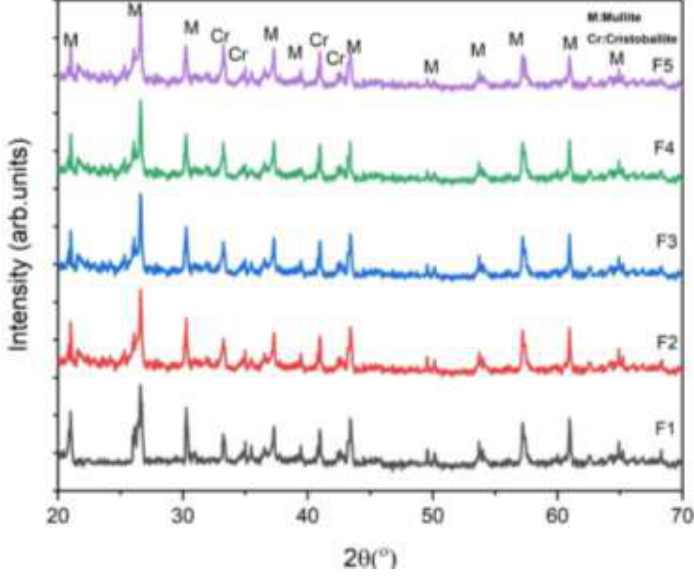
Figure 2: The XRD pattern of the prepared